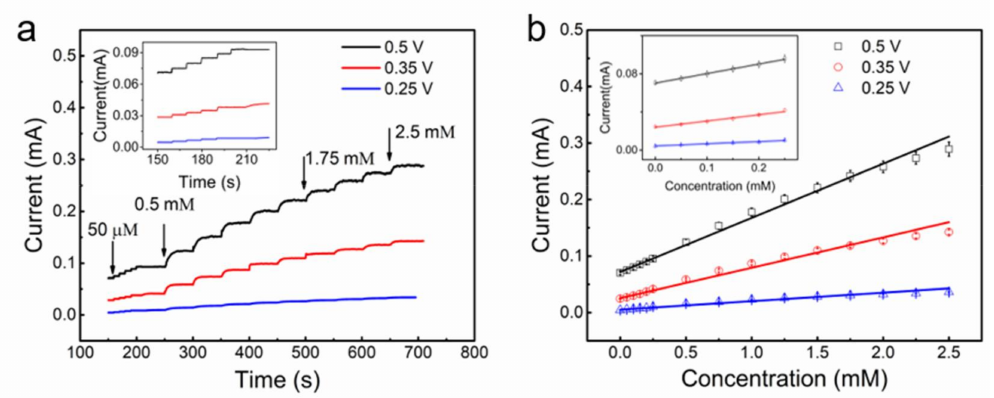
Figure 6. ( a ) Current as a function of time of the (Cu 13nm -CNTS) 3 @fiber electrode at different applied potentials in PBS solution by dropwise addition of glucose. ( b ) The calibration curve of the current as a function of concentration of the (Cu 13nm -CNTS) 3 @fiber electrode at different applied potential, nine samples (three samples from three separate batches) are used here to get the average